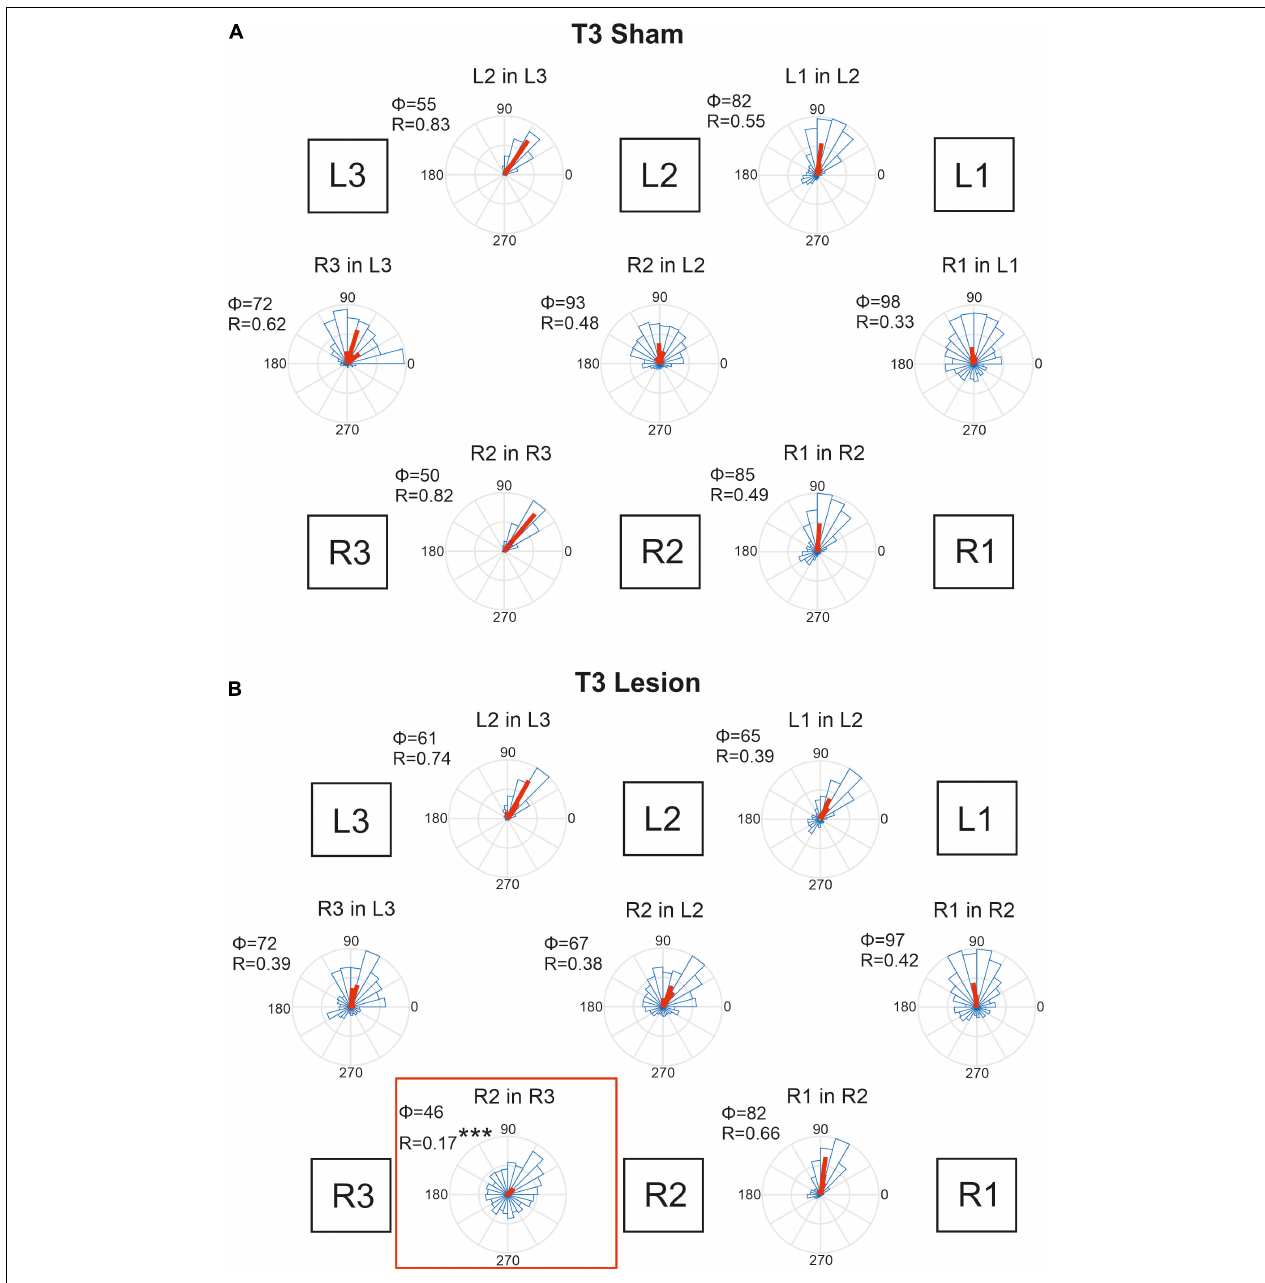
FIGURE 10 | Temporal coordination of step cycles after an operation in the metathorax. (A) Sham-operated animals. (B) Animals with a lesion of the right meso-to-metathorax connective (T3 lesion). Same graph details as for Figure 9 . Significance level *** p < 0.001.